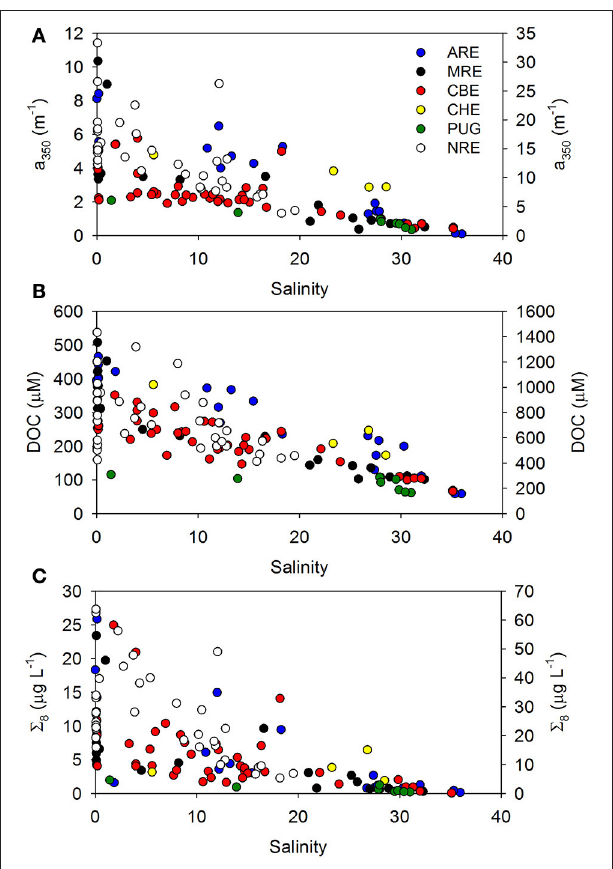
FIGURE 3 | Trends in (A) a 350 , (B) DOC concentration, and (C) sum of 8 lignin-derived phenols ( 6 8 ) with salinity. Colors denote the individual points from the six estuaries studied. Neuse River estuary (NRE) samples are plotted on the right axis of each figure.